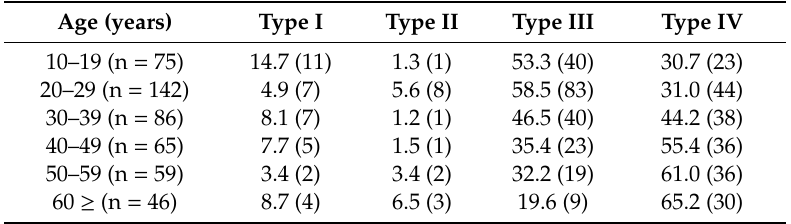
Table 2. Distribution of the four types according to age %